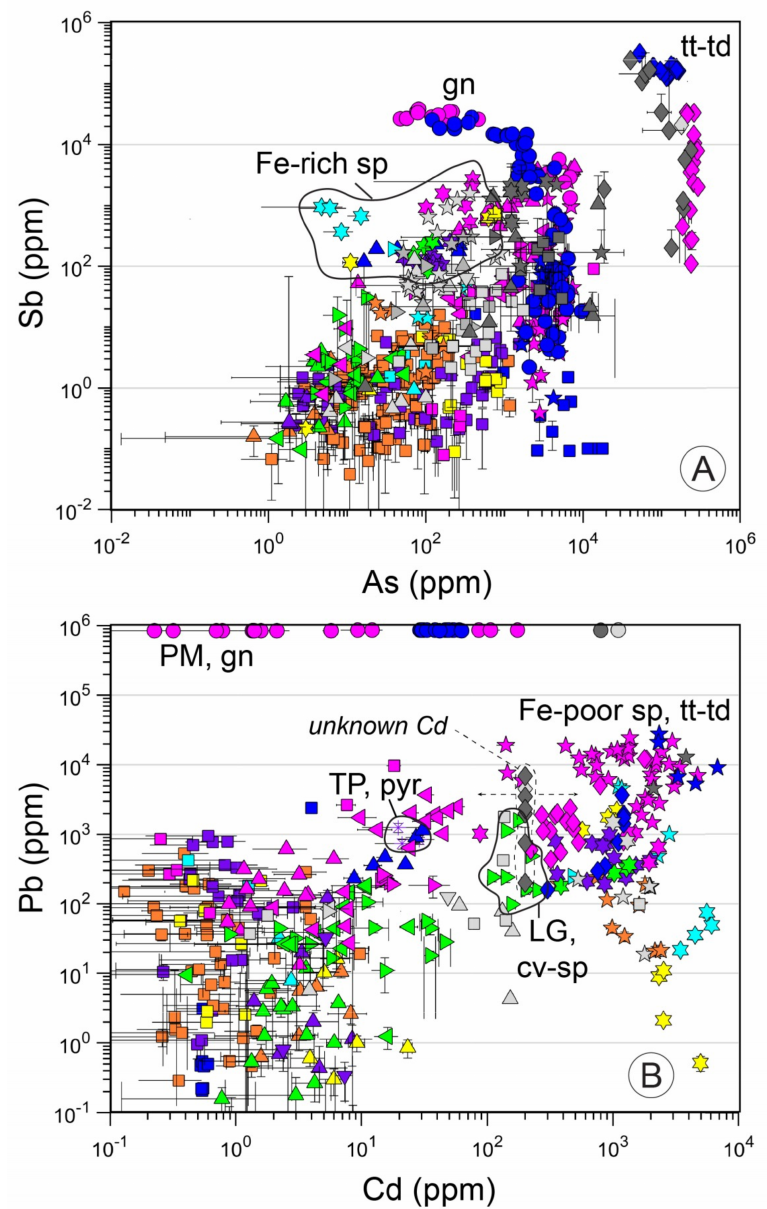
Figure 5. Logarithmic plots displaying a comparison of trace element concentrations (ppm) of ( A ) As versus Sb ( B ) Cd versus Pb in sulfide minerals from all hydrothermal vent sites investigated during this study. Abbreviations of hydrothermal sites used in this figure include LG ( Logatchev ), and TP ( Turtle Pits ). Abbreviations of minerals used in this figure include sp ( sphalerite ), gn ( galena ), tt-td ( tennantite-tetrahedrite ), pyr ( pyrrhotite ) and cv ( covellite ). Shape denotes the type of mineral where squares: pyrite/marcasite, asterisks: pyrrhotite, triangles: Cu phases including downward-pointing triangle: isocubanite, upward-pointing triangle: chalcopyrite, right-pointing triangle: covellite/digenite/chalcocite, left-pointing triangle: bornite, diamond: tennantite-tetrahedrite, five-pointed star: Fe-poor sphalerite, six-pointed star: Fe-rich sphalerite, circles: galena. Colour dictates the tectonic setting where green: ultramafic-hosted MOR (Logatchev), orange: mature MOR (TAG), purple: high temperature MOR (Turtle Pits), cyan: immature MOR (SEPR), yellow: hot spot MOR (AS), magenta: back-arc basin (PM), blue: volcanic arc (PVC). Shown for comparison are data from the literature in grey-scale outlined in Table S8 (light grey: MOR, middle grey: ultramafic MOR and dark grey: